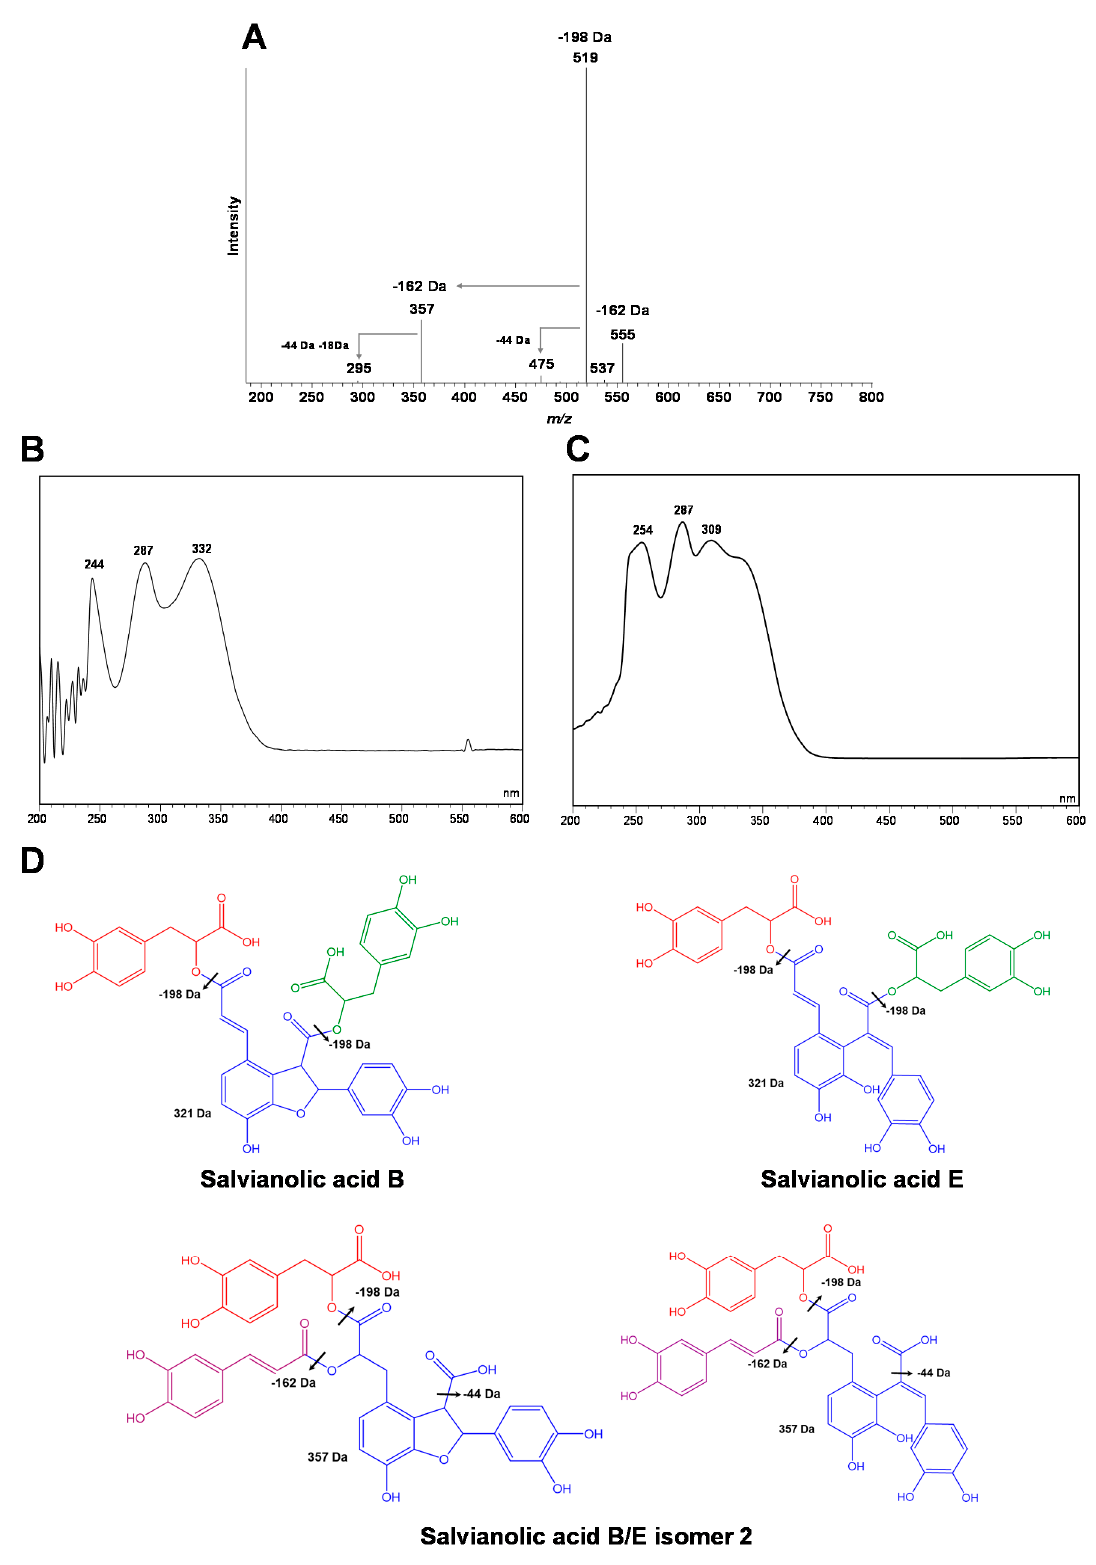
Figure 2. ESI-MS 2 ( m / z = 717) ( A ) and UV-VIS ( B ) spectra of salvianolic acid B / E isomer 2, UV-VIS spectrum of salvianolic acid B standard ( C ) and fragmentation of salvianolic acids B and E with two possible structures, and respective fragmentation, of salvianolic acid B / E isomer 2 ( D ).